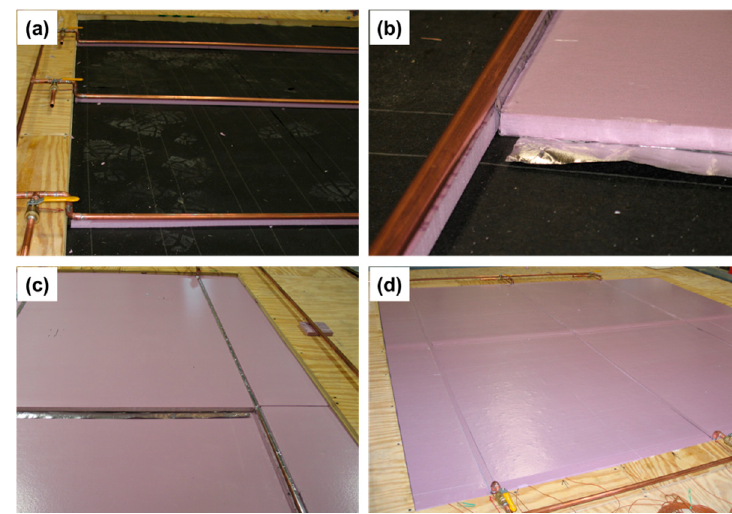
Figure 2. COMSOL rendering of the schematic cross-section of the “Base + TAC” wall.